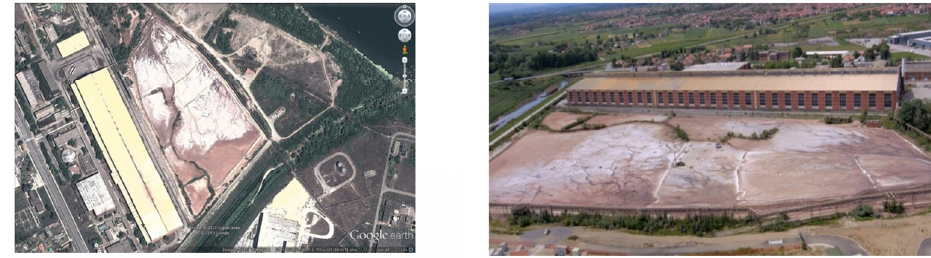
Figure 1. View of jarosite waste tailings at the Elixir Zorka Šabac